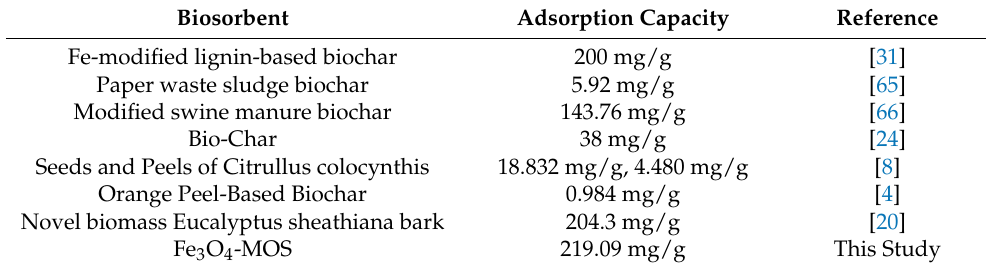
Table 4. Comparison of biosorption capacities of different biosorbents for MB dye